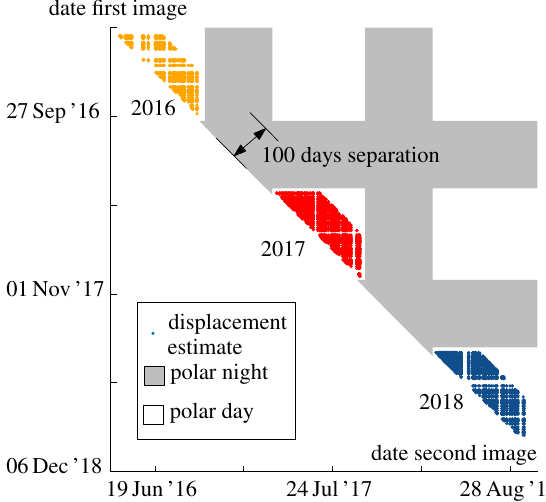
Figure 2. Temporal distribution of velocity fields. The shaded gray regions denotes the polar night when optical imagery is not available. Because of the limited timespan of 100 days, three distinct time periods are formed.